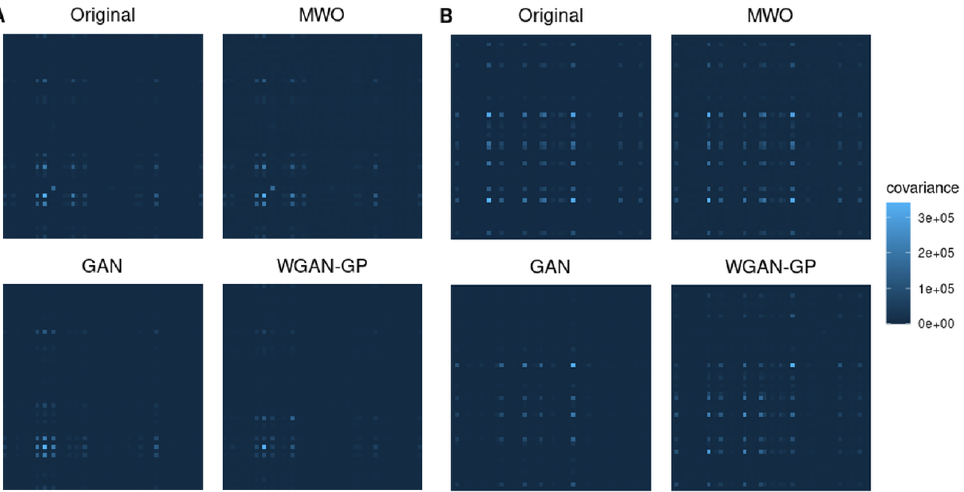
Figure 6. Heatmaps illustrating covariance matrices for the RNA-seq data study. Comparison of covariance matrices of original and artificial samples for two sets of 50 randomly chosen genes. The details are showed in ( A , B